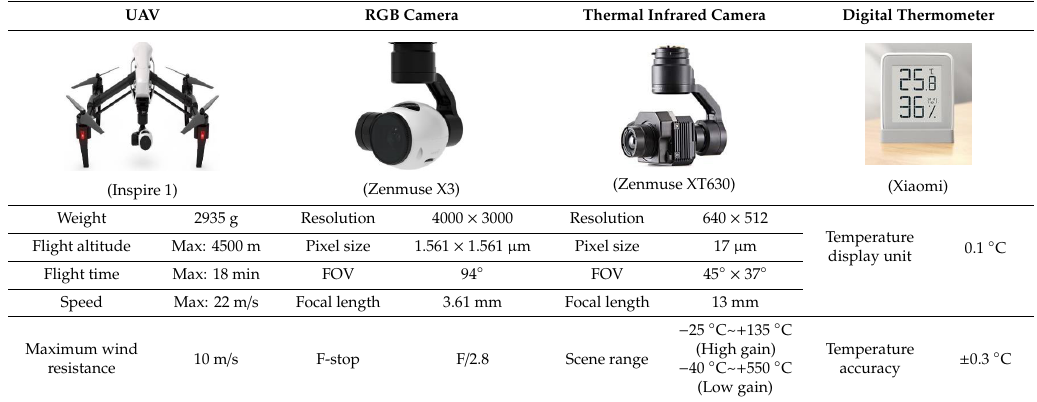
Figure 3. Fourth floor of building No. 9 used for the temperature measurement.